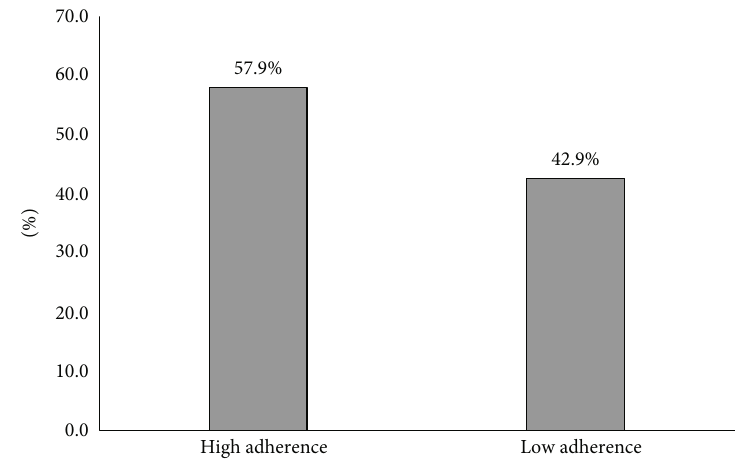
Figure 1: Classi fi cation of the study participants according to their adherence